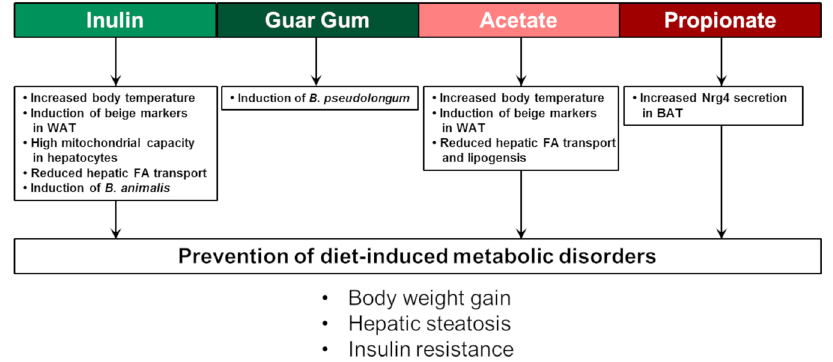
Figure 5. Overview of dietary fibre- and SCFA-mediated metabolic effects to accomplish the prevention of diet-induced metabolic disorders. WAT: White adipose tissue; FA: Fatty acid; Nrg4: Neuregulin 4; BAT: Brown adipose